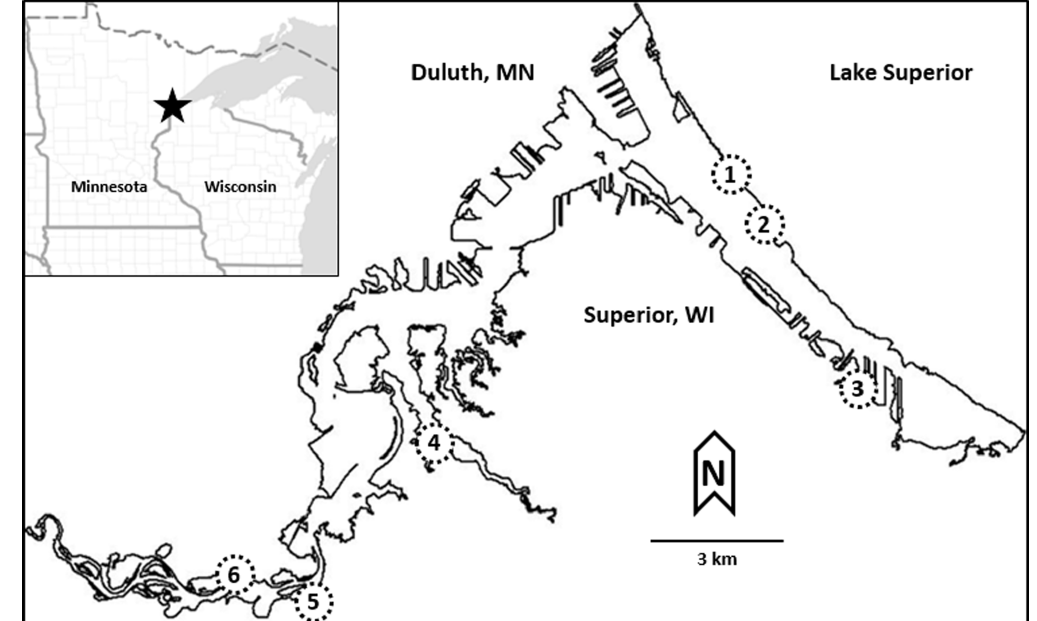
Figure 1: In-person angler survey sites on the SLRE indicated by dashed circles. Sites 1 and 4 are walk-in accesses typi- cally used by anglers only during the ice-fishing season, and the rest are boat accesses used by anglers year